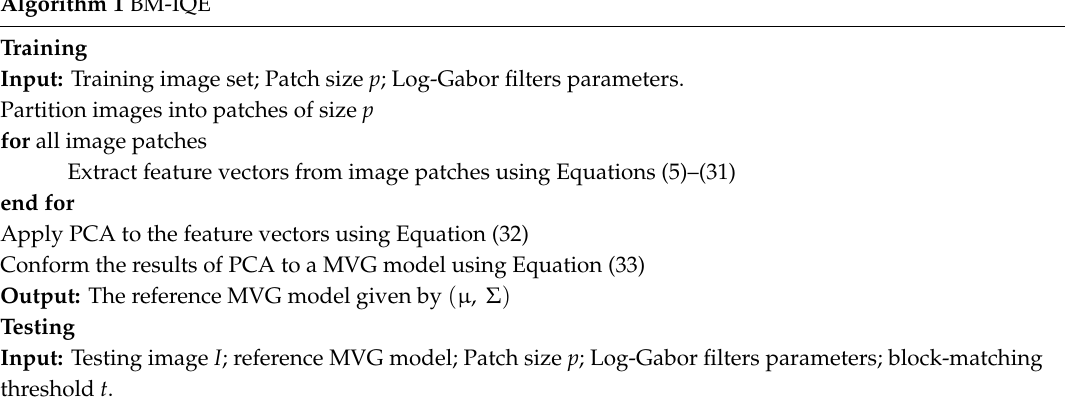
Algorithm 1 BM-IQE